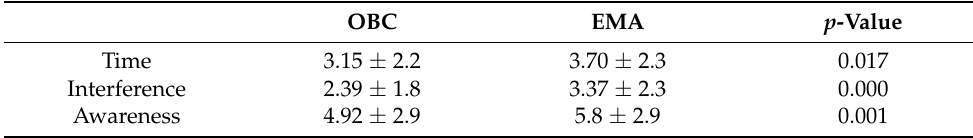
Table 7. Scores of the three domains of the satisfaction questionnaire, concerning the two tools adopted for the Oral behaviours (OB) measurement, and results of the paired-sample t-test. Data are shown as mean ± standard deviation. OBC: Oral Behaviours Checklist; EMA: Ecological Momentary